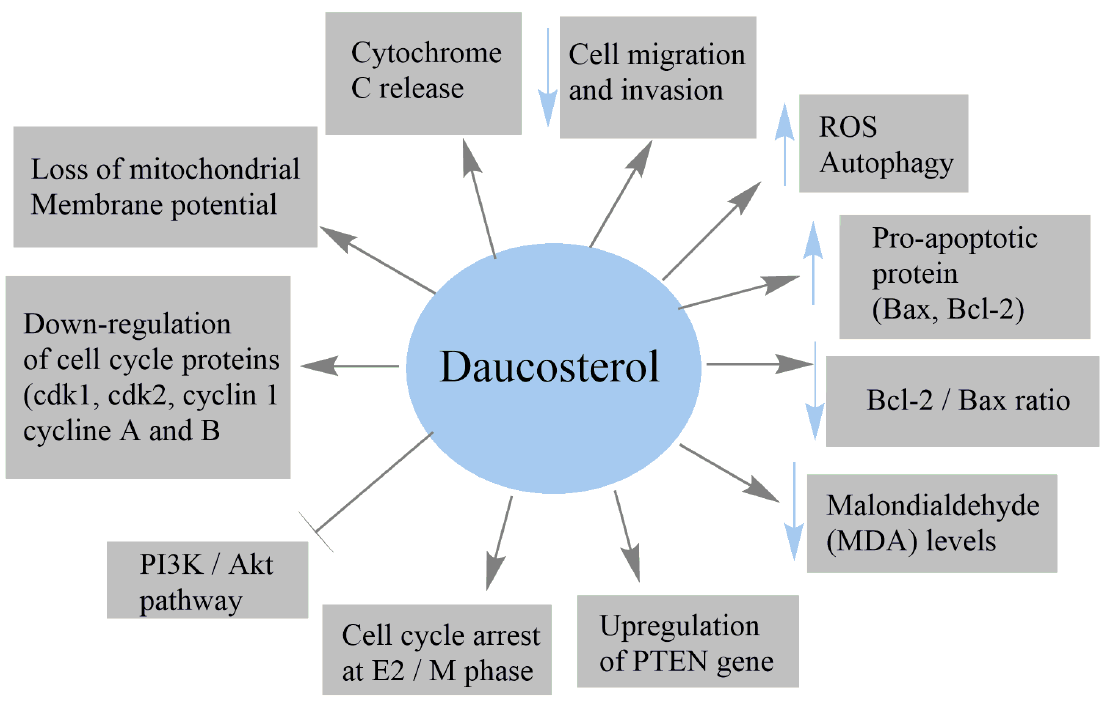
Figure 4. Anti-inflammatory mechanisms of Daucosterol. The arrow indicates increasing, decreasing or inhibiting. or